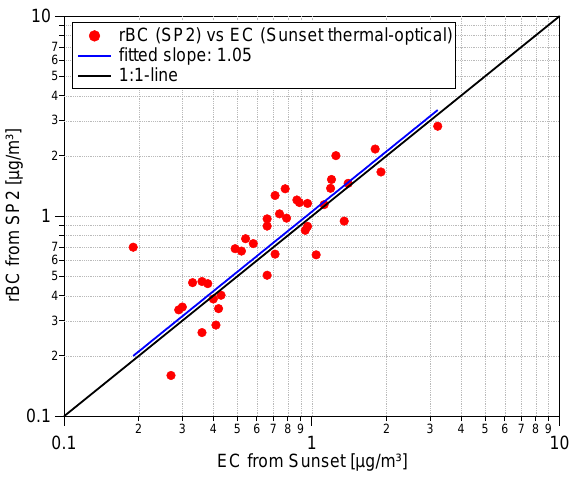
Fig. 1. Comparison between EC from the Sunset OCEC analyser and rBC from the SP2 for the whole campaign (12h average val-